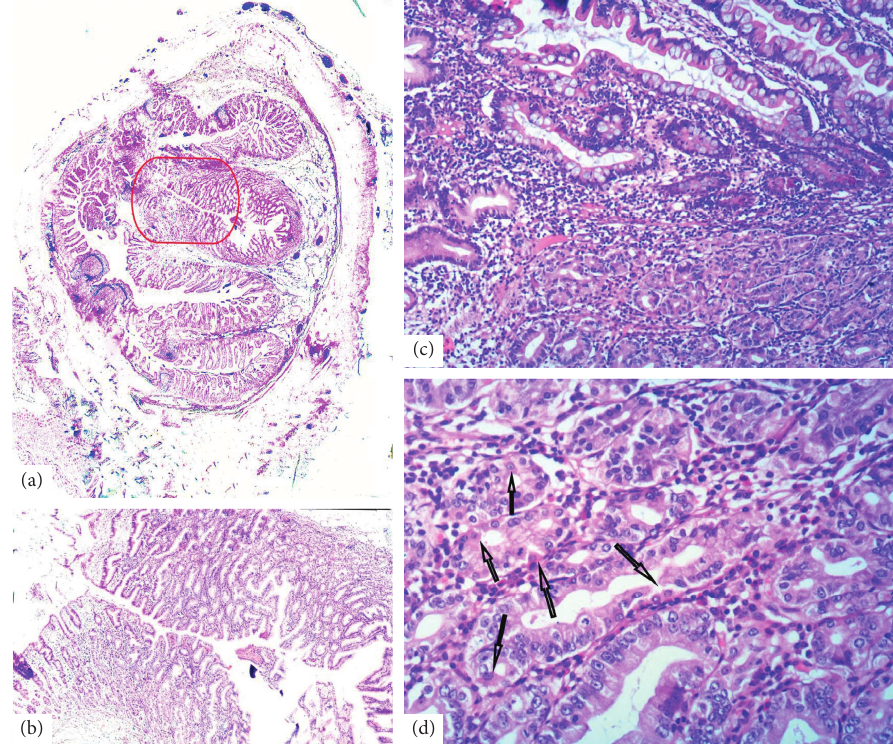
Figure 3: (a) HeEo (x5): cross section of the diverticulum. Gastric mucosa is delineated with a red line. (b) HeEo (x40): the section with gastric mucosaathighermagnification.(c)HeEo(x100):marginbetweenintestinal(upperhalf)andgastricmucosa(lowerhalf).(d)HeEo(x200):someof the parietal cells in the gastric mucosa (arrows), with a deeply eosinophilic cytoplasm as opposed to the mucinous and chief